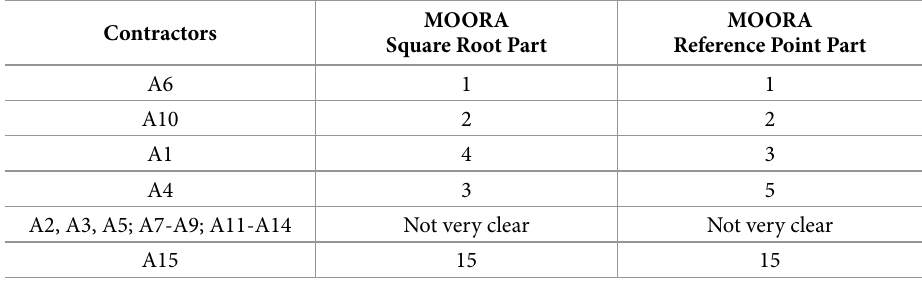
table 4. No discussion on the ranking of the first four positions of the 15 contractors after the 2 parts of MOORA contractors